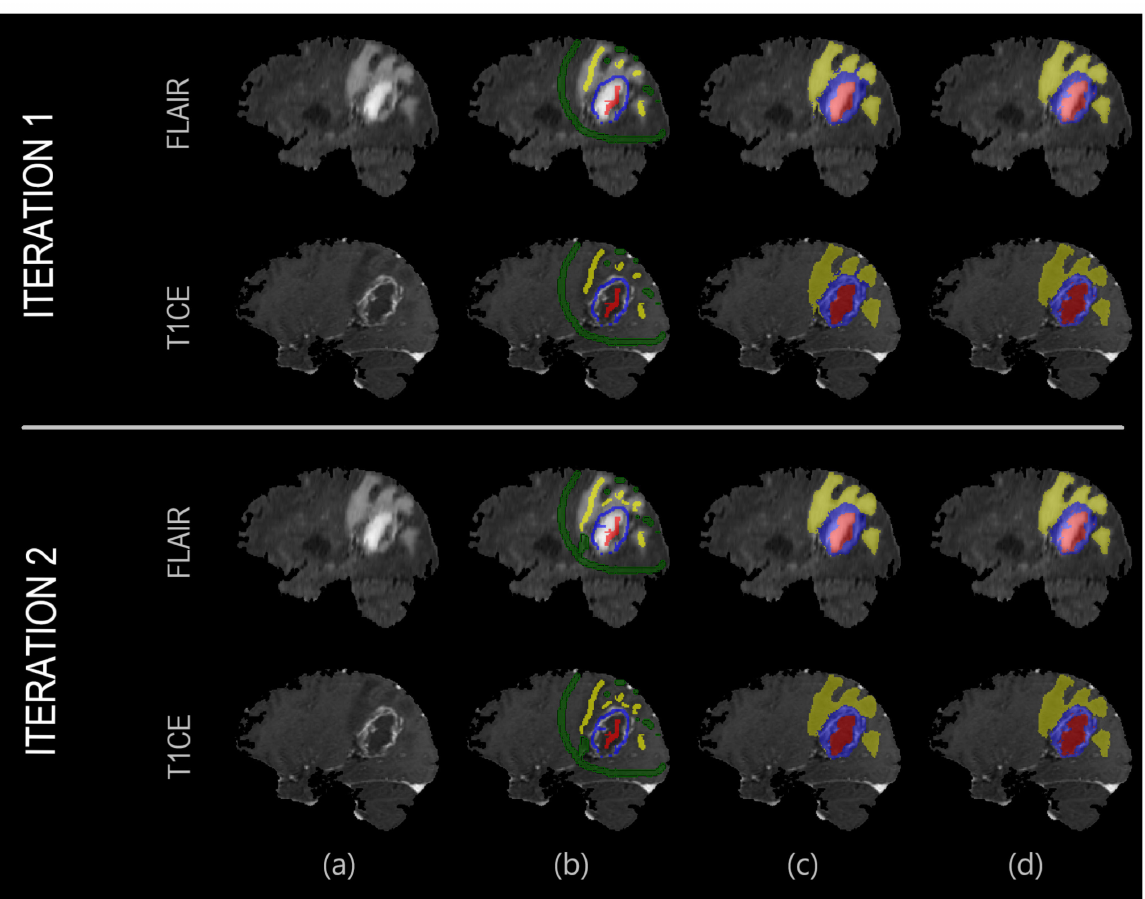
Figure 1. Example showcasing the result improving as a function of invested time. In the first iteration, the user quickly draws over the different areas. In the second iteration, the user places few additional labels to correct representative misclassified areas, which are then used to retrain the machine learning model. From left to right: ( a ) Anatomical image;